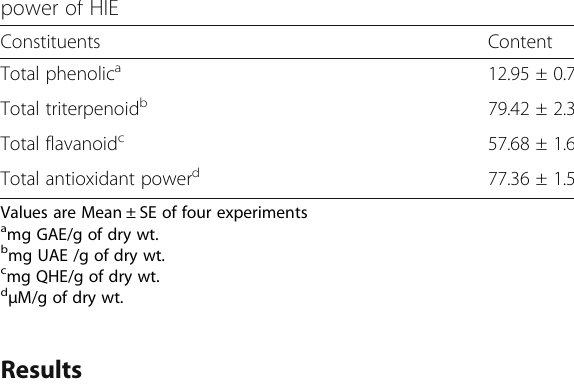
Table 1 Estimation of phytoconstituents and total antioxidant